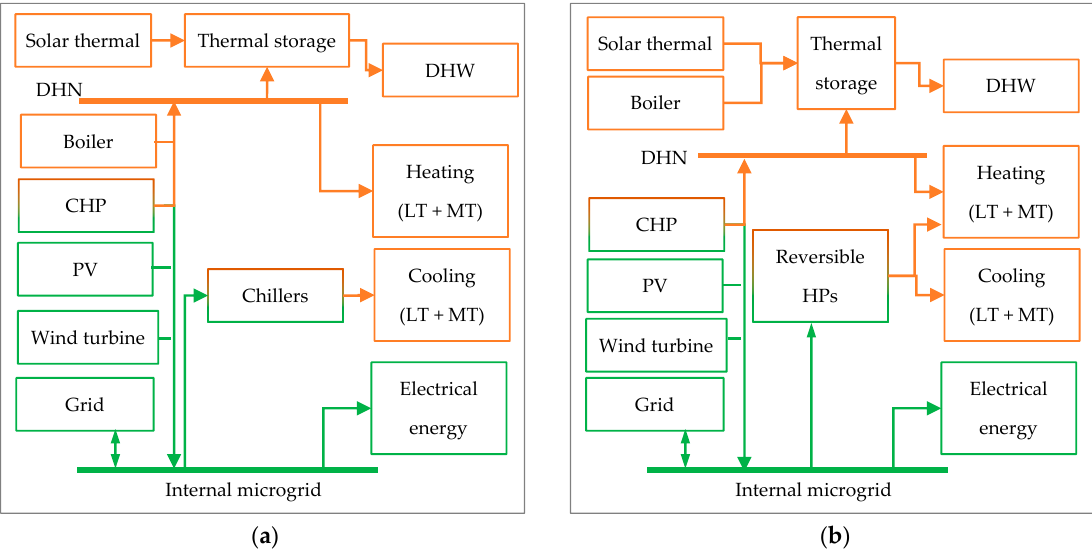
Figure 4. Analyzed configuration for the reference multi-energy microgrid: ( a ) centralized, ( b ) distributed. The generators concur to satisfy the heating/cooling/DHW/electrical energy requirements of the campus with the following